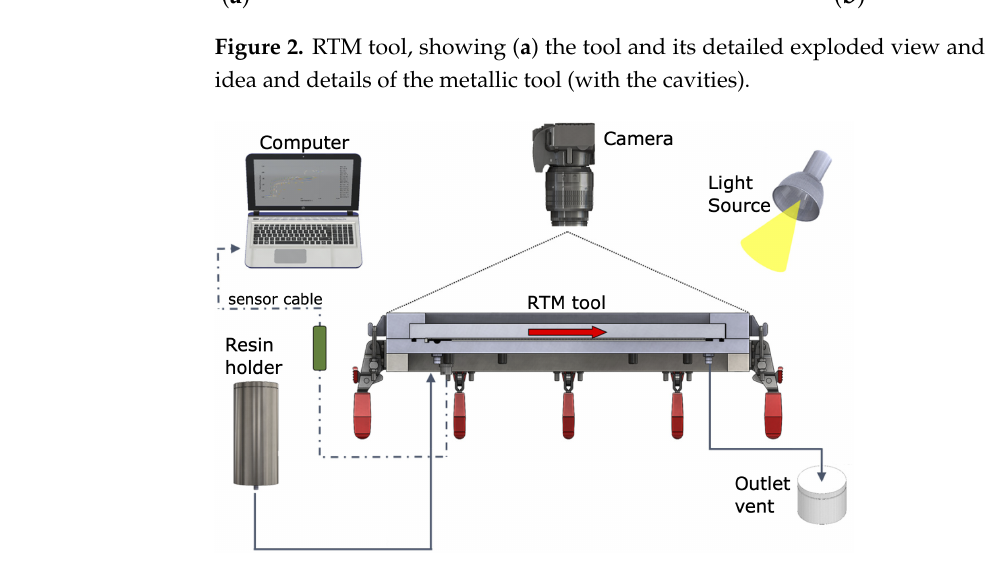
Figure 3. Experiment setup along with the measuring